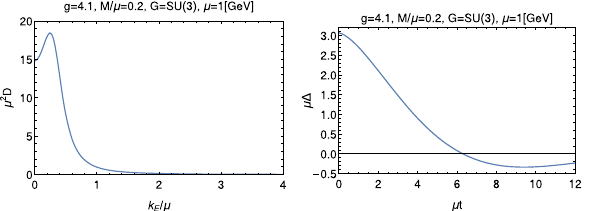
Fig. 10 The same plots as those given in Fig. 7 for a physical coupling constant g = 4 . 1 and a smaller mass M /μ = 0 . 2